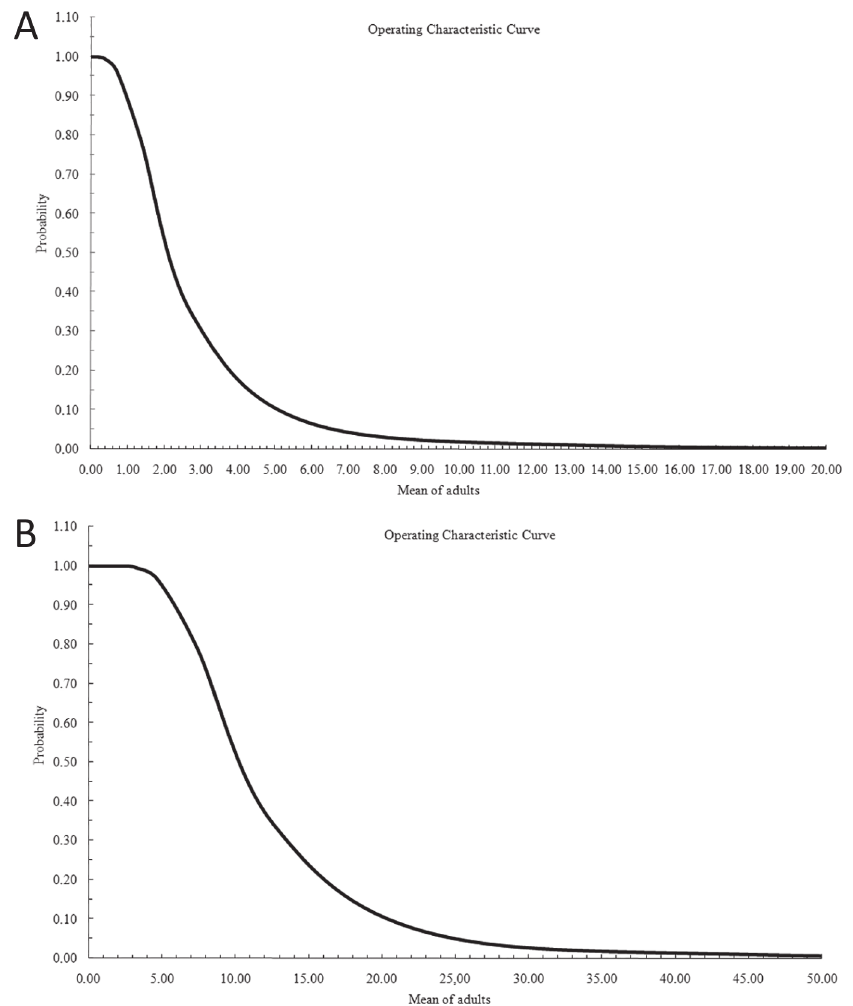
Figure 2 - Operating characteristic curve OC(p) of the Test Sequential Probability Ratio for the total adult population of Bemisia tuberculata (Hemiptera: Aleyrodidae) to the biological (A) and chemical (B)